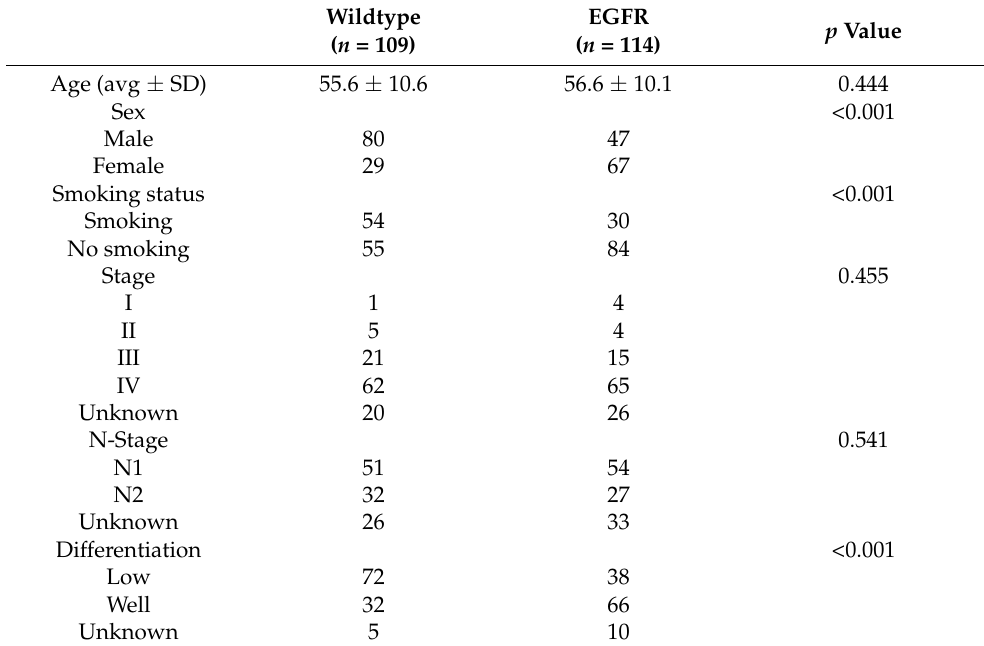
Table 1. Validation cohort patient